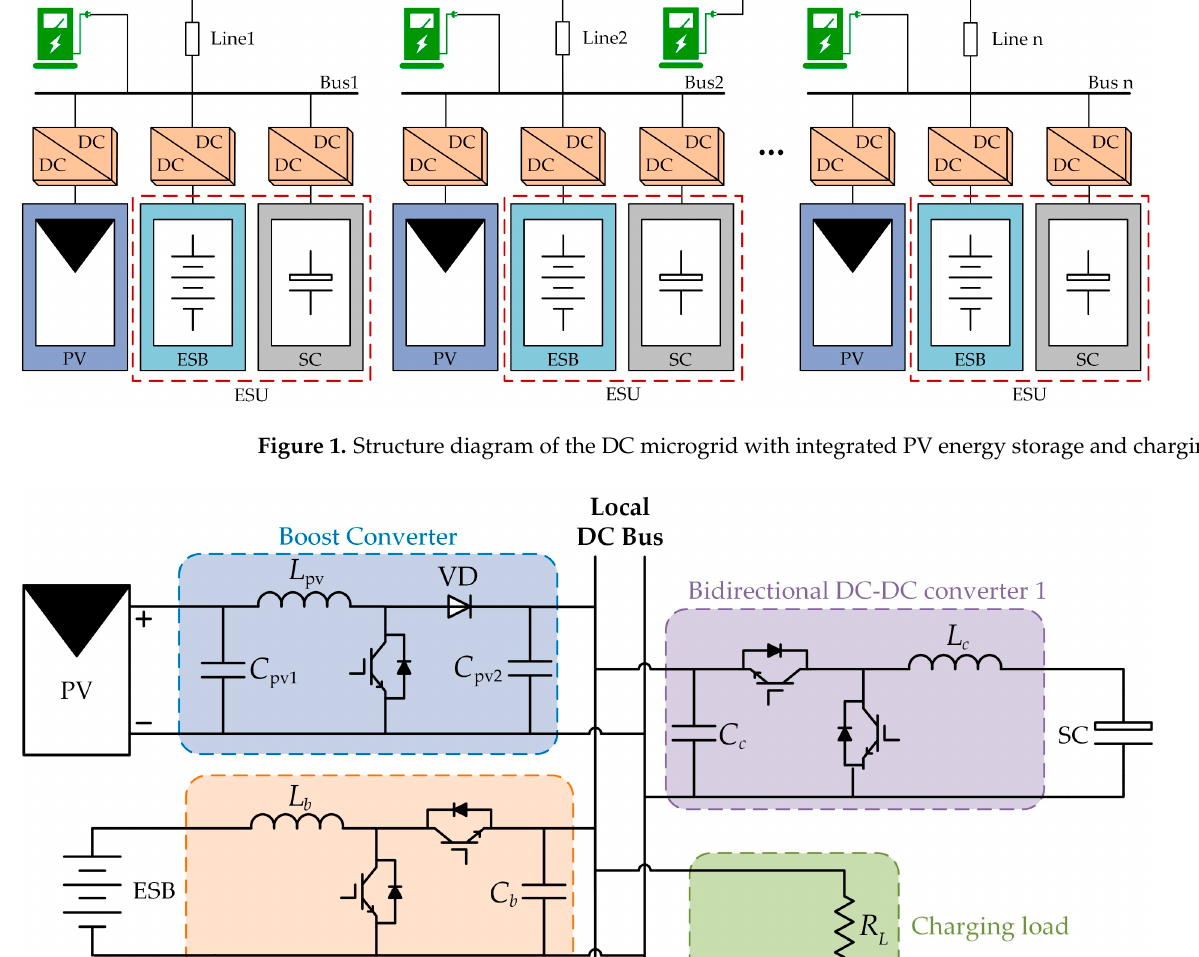
Figure 1. Structure diagram of the DC microgrid with integrated PV energy storage and charging.